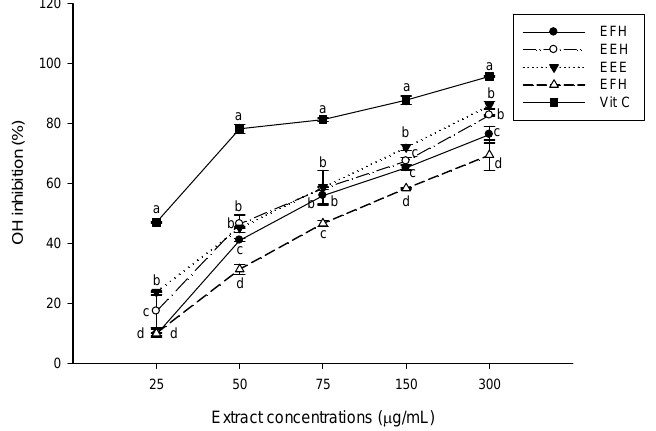
Figure 2. Hydroxyl radical (OH) scavenging potential of the different plant extracts. Values are expressed as mean ± SD of three replicates. In the same concentration the values affected with different letter are significantly different at p < 0.05. EEE: H. zenkeri ( bark) ethanolic extract; EFE: H. zenkeri (leaves) ethanolic extract; EEH: H. zenkeri (bark) hydro-ethanolic extract; EFH: H. zenkeri (leaves) hydro-ethanolic extract; Vit C: Vitamin C.